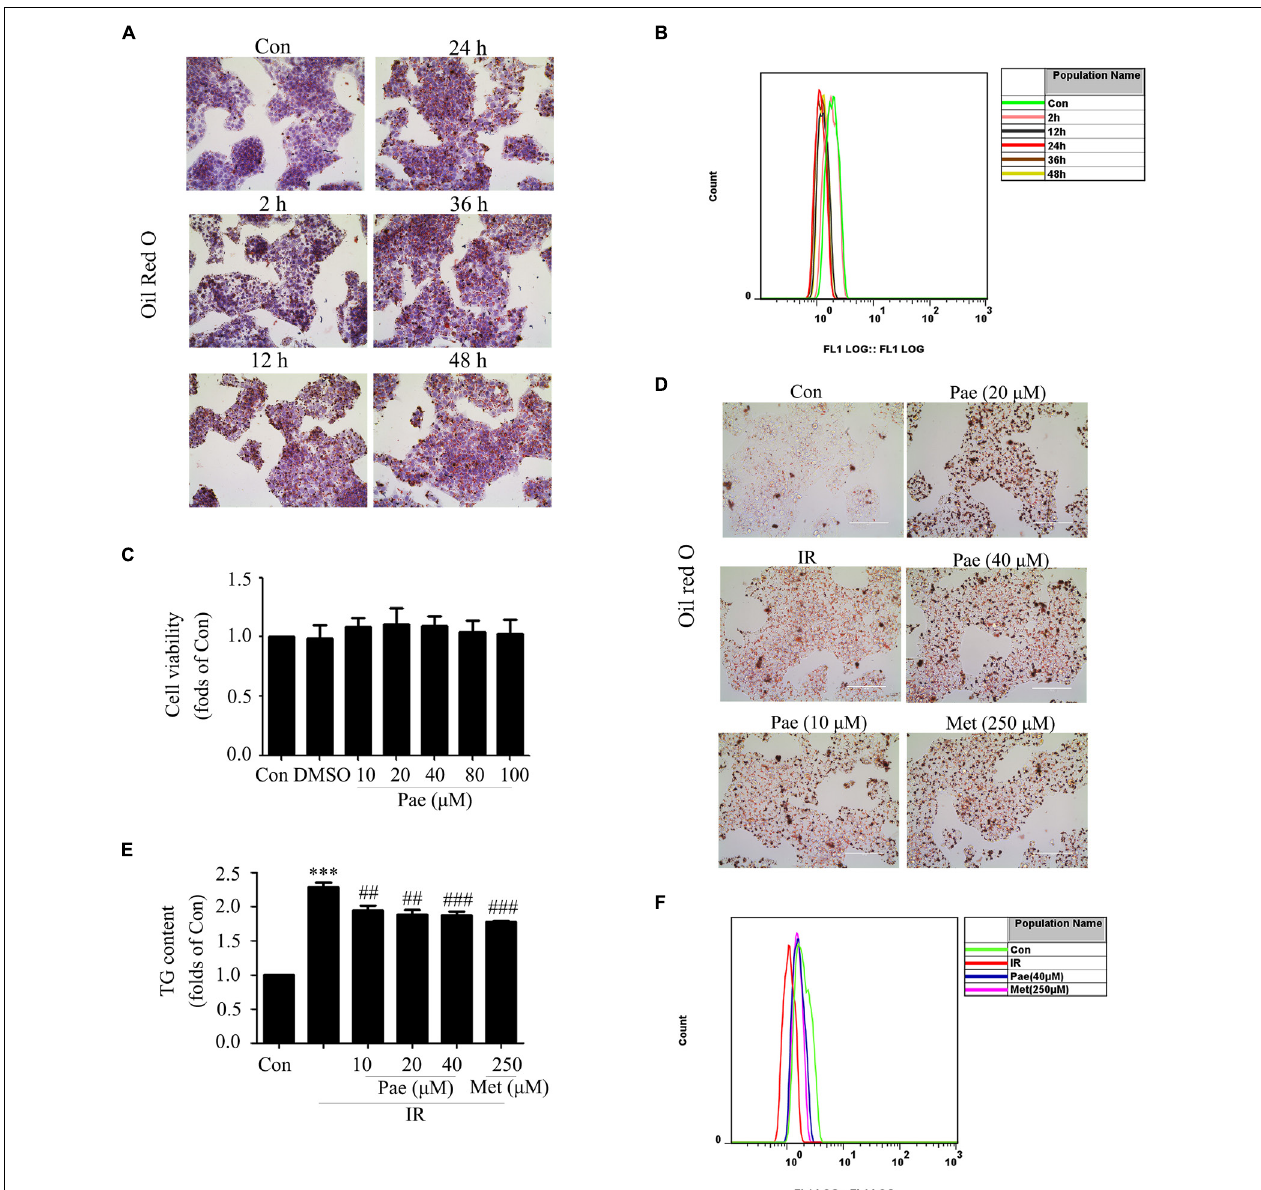
FIGURE 3 | Paeonol improved lipid accumulation and glucose utilization in insulin-resistant HepG2 cells. (A,B) Oil Red O staining and glucose uptake of HepG2 cells treated by palmitic acid for different times. (C) Cell survival analysis through MTT assay of HepG2 cells treated with different concentrations of paeonol for 24 h. (D) The effects of paeonol on lipid accumulation assessed by Oil Red O. (E) Quantity analysis of triglyceride. (F) Glucose uptake assessment in paeonol-treated HepG2 cells under palmitic acid conditions. Con represents the control group; IR represents insulin-resistant group. ∗∗∗ p < 0.001 vs. Con; ## p < 0.01 and ### p < 0.001 vs.